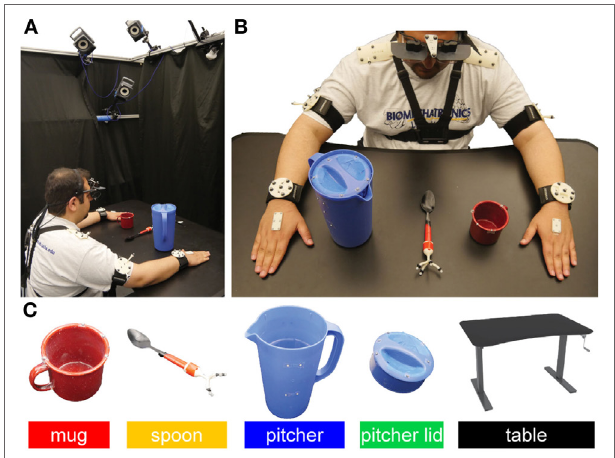
FigUre 1 | (a) Each subject was seated in the motion capture area. A blackout curtain was used to minimize visual distractions. (B) The subject wore a head-mounted eye tracker. Motion capture markers were attached to the Yale-CMU-Berkeley objects, the eye tracker, and subjects’ upper limbs. Each trial used the object layout shown. (c) Retroreflective markers were placed on a mug, spoon, pitcher, pitcher lid, and table. These objects will be referenced using the indicated color code throughout this manuscript. The subject shown in panels (a,B) has approved of the publication of these